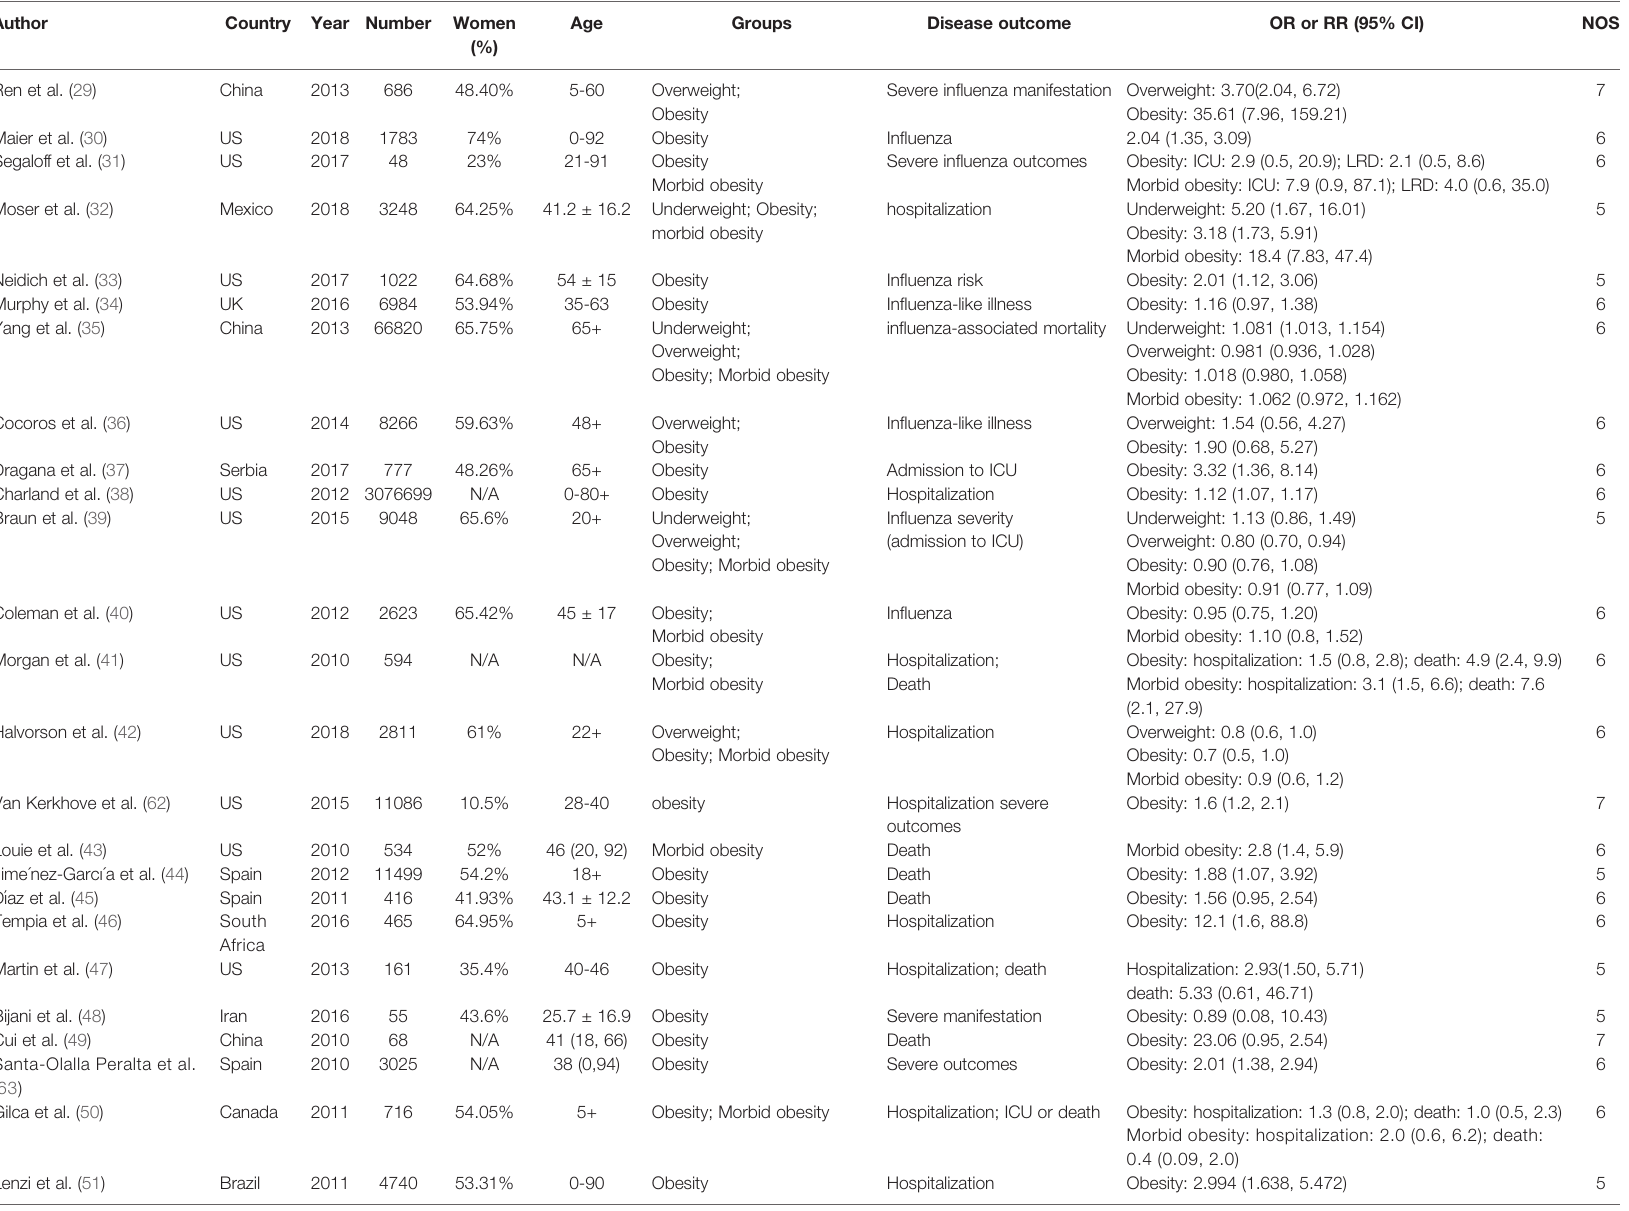
TABLE 1 | Characteristics of included studies on the infection, hospitalization, severity, and mortality of in fl uenza. Author